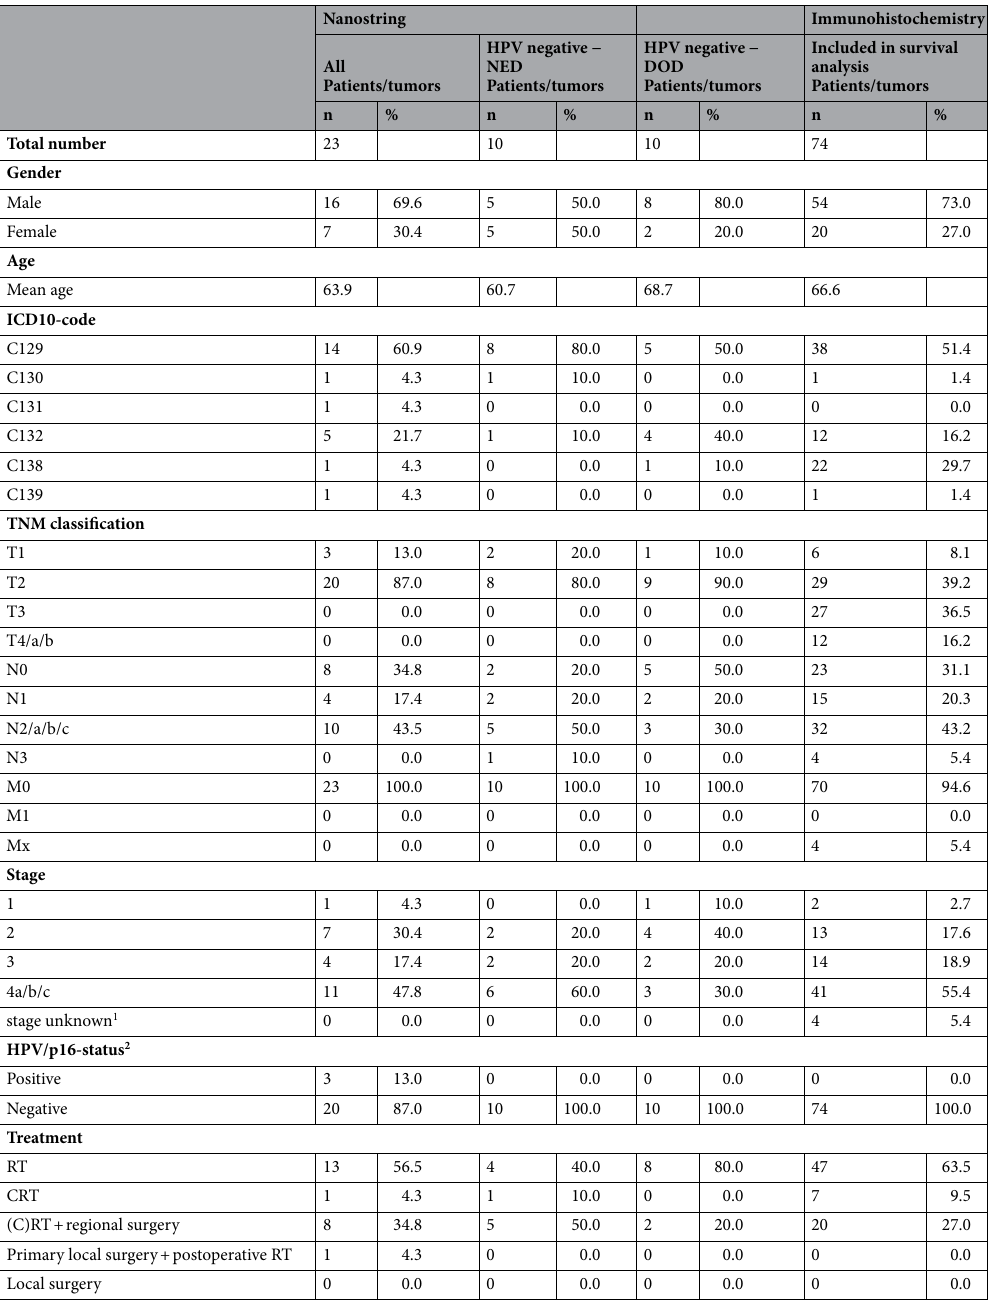
Table 1. Patient and tumor characteristics. RT radiotherapy, CRT chemoradiotherapy. 1 Stage unknown due to lack of information on N- and/or M-stage. 2 Positive status defined by both presence of HPV DNA and overexpression of